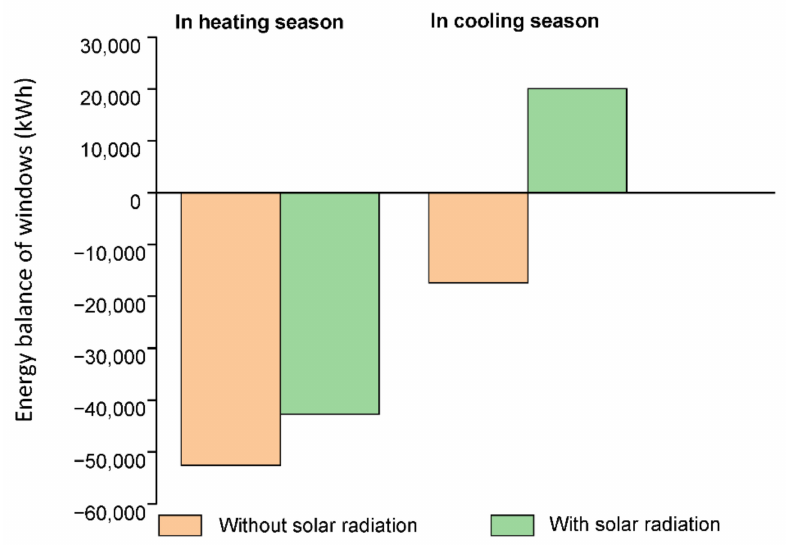
Figure 13. Energy balance of windows with and without considering solar radiation in case A (no low-E film).